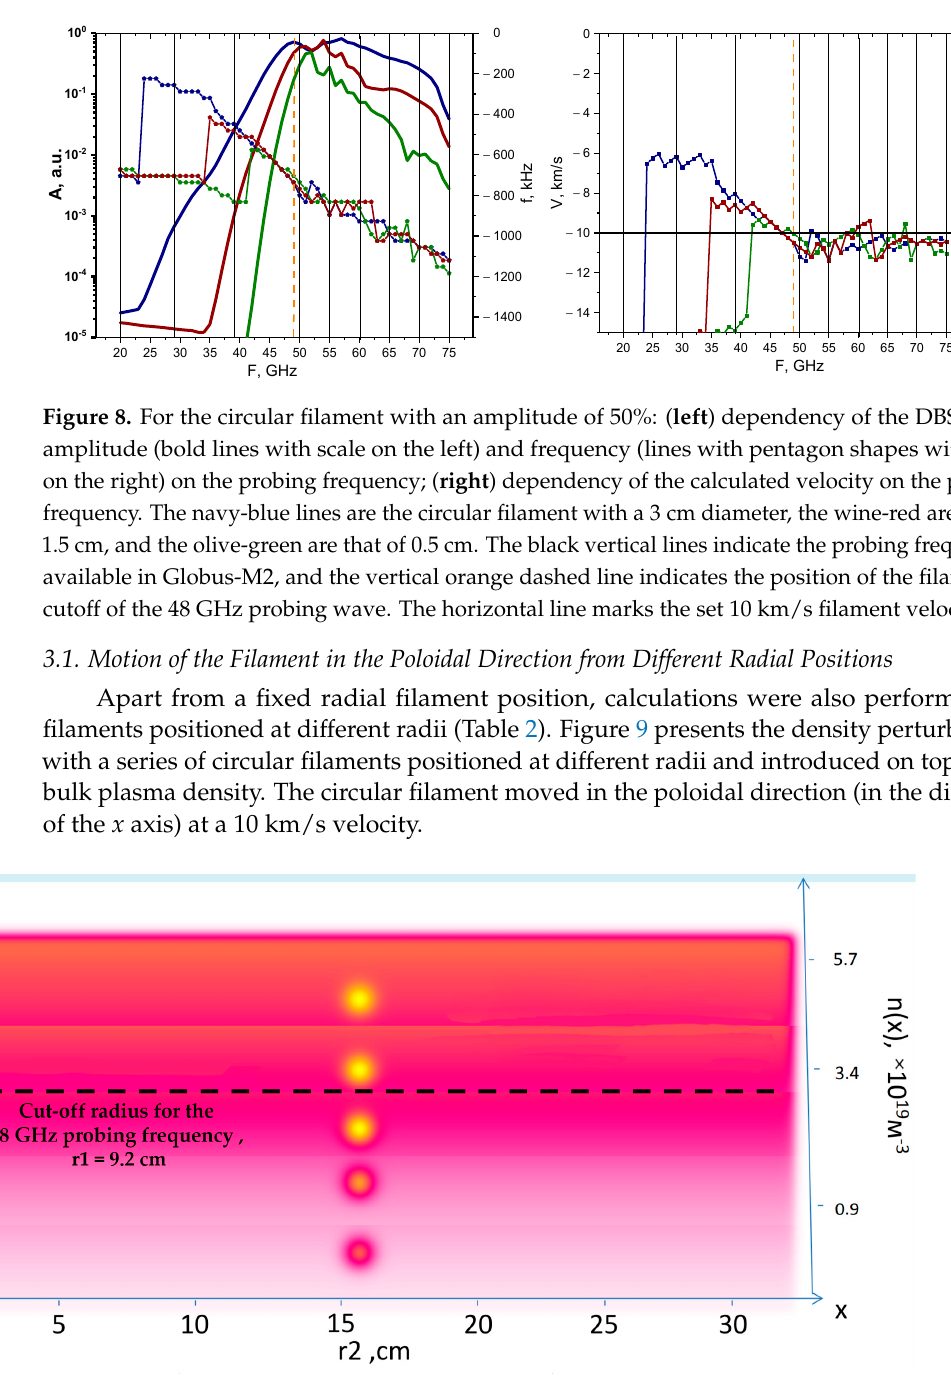
Figure 10. The dependency of the signal amplitude on the radial position of the circular filament of ( left ) 0.5 cm diameter and ( right ) 3 cm diameter. The red line corresponds to the filament with an amplitude of 1% of density at cutoff of the probing wave 48 GHz where the filament was positioned, and the black line corresponds to an amplitude of 100%. The signal frequency was investigated for the 0.5 cm filament. It is presented in Fig- ure 11 and is depicted by the red line. In both the linear and non-linear cases, the signal frequency coincided with the frequency predicted by the formula for the Doppler shift in the Born approximation (red horizontal line) only when the filament was positioned in the cutoff of the given frequency. For all other positions, the frequency values were lower.